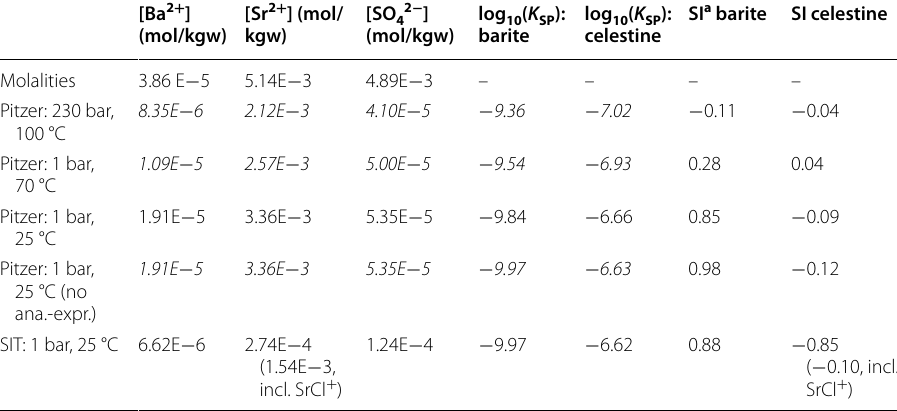
Table 1 PhreeqC 3 modelling results: aqueous activities, solubility products ( K uration indices